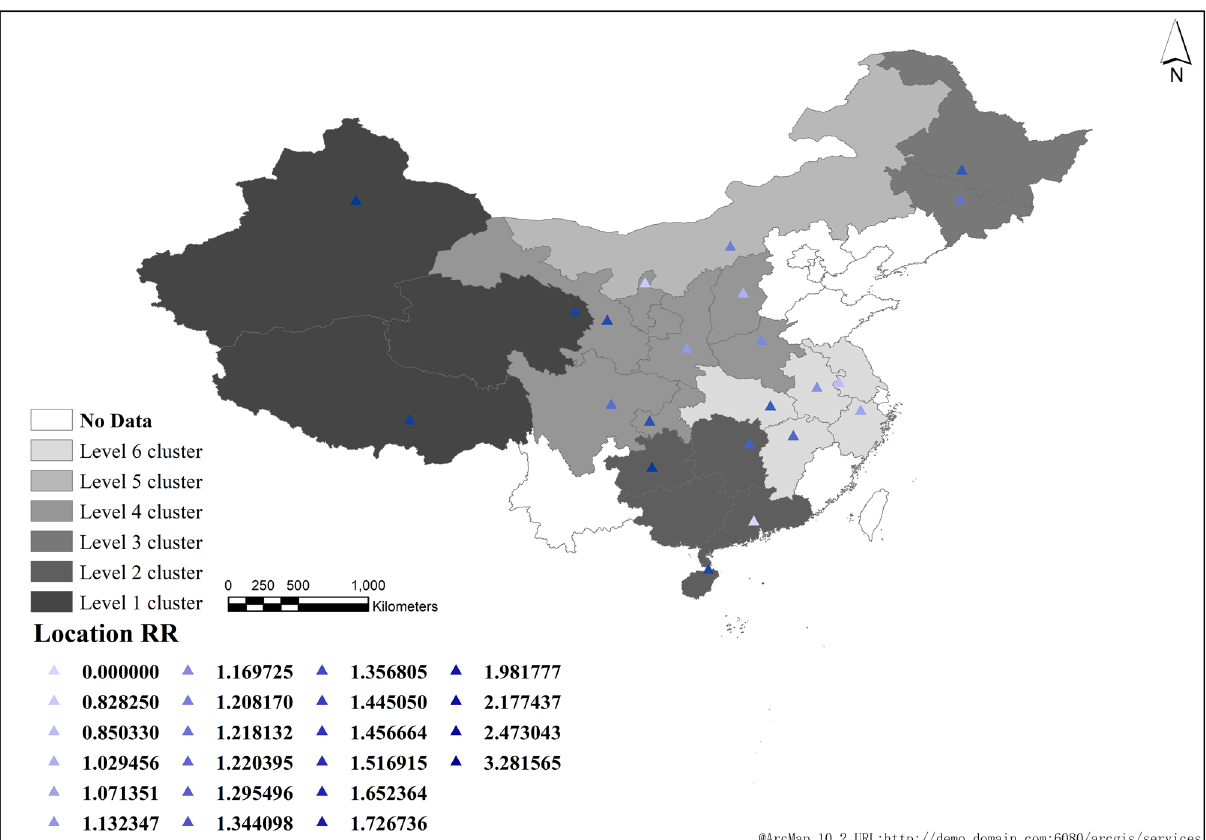
Figure 4. Space–time scanning analysis of reported cases of pulmonary tuberculosis in China from 2008 to